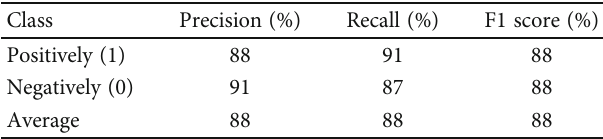
Table 13: Performance metrics using the IMDB dataset (DSC) on sentiment classi fi cation.